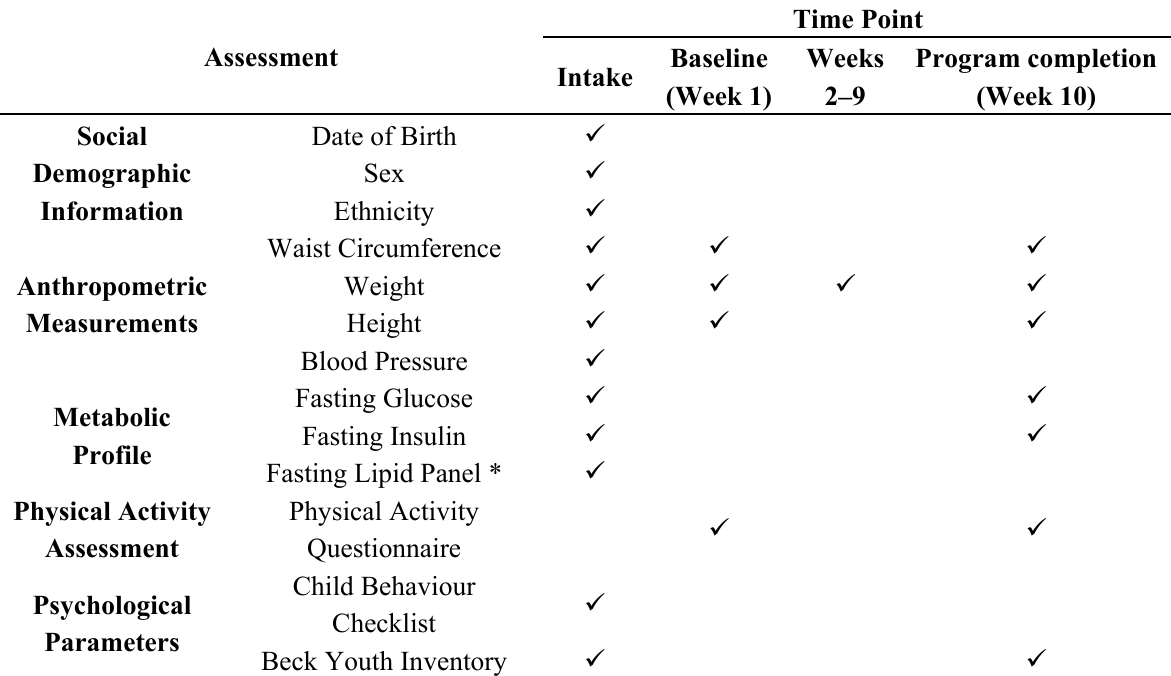
Table 1. Summary of data collected by time